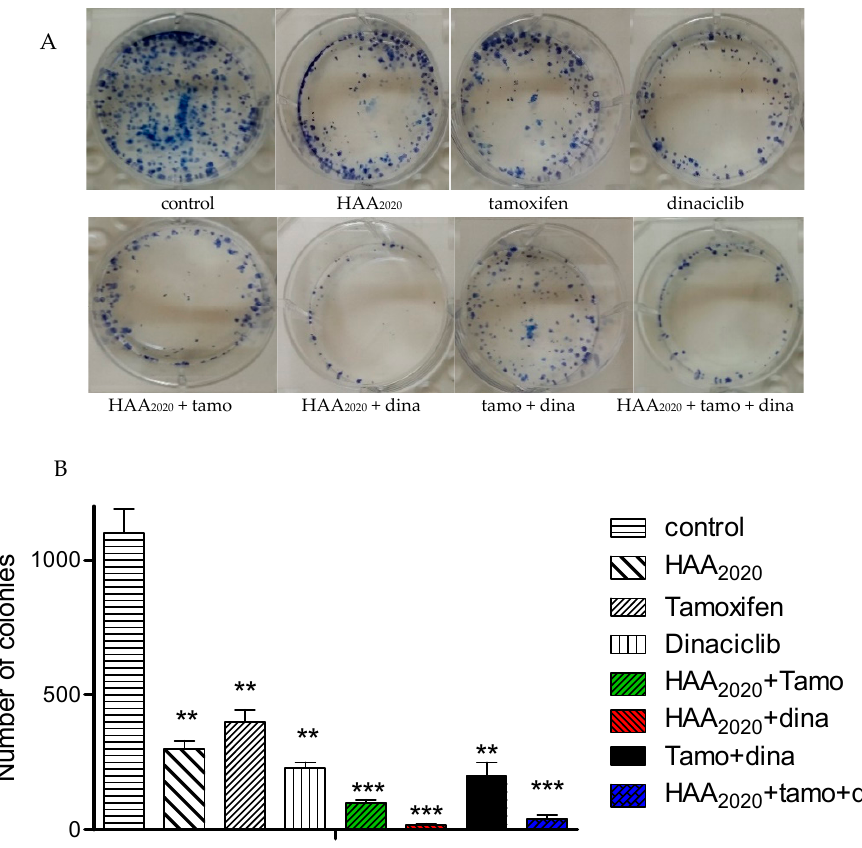
Figure 4. Clonogenicty of HAA 2020 , tamoxifen, dinaciclib, and their combinations in MCF7 cells (24 h), followed by 14 days of drug-free incubation. ( A ) MCF7 colonies in 6-well plates stained with methylene blue. ( B ) Bar figure showing the effect of each compound/combination ( n = 3). Experiments were repeated ×3 times. Statistical differences compared to untreated control cells were assessed by one-way Anova with the Tukey’s post-hoc multiple comparison test. p < 0.01 (**) and p < 0.001 (***) were taken as significant.